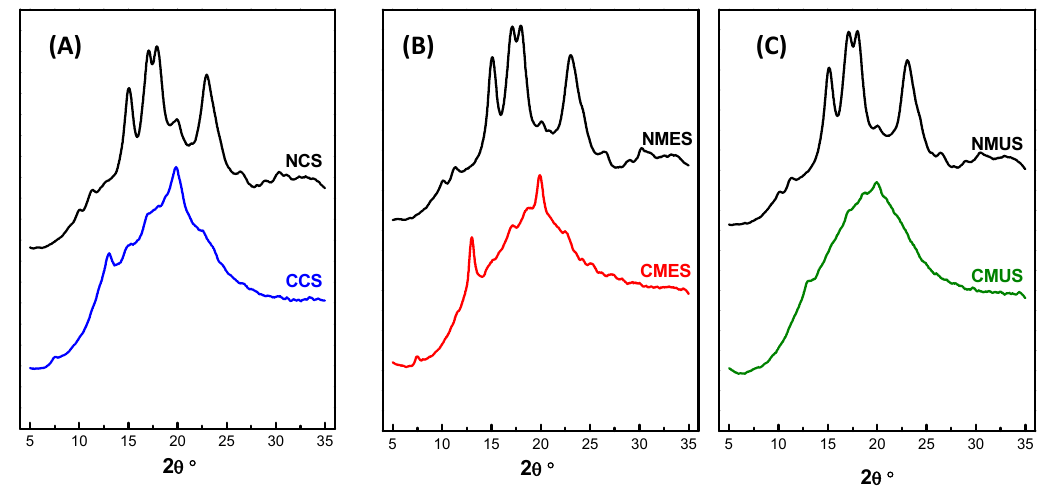
Figure 2. XRD profiles of ( A ) corn starch (CCS) grafted starch and its corresponding native corn starch (NCS), ( B ) bitter cassava (CMES) grafted starch and its corresponding native bitter cassava starch(NMES), and ( C ) sweet cassava (CMUS) grafted starch and its corresponding native sweet cassava starch (NMUS).